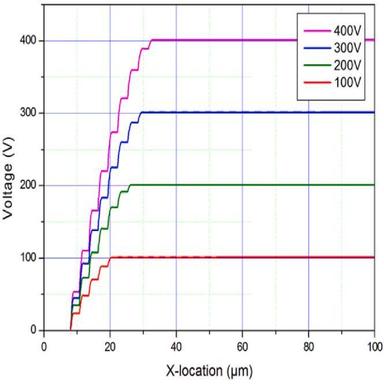
Equipotential distribution along the structure. The voltage step is 100 V.